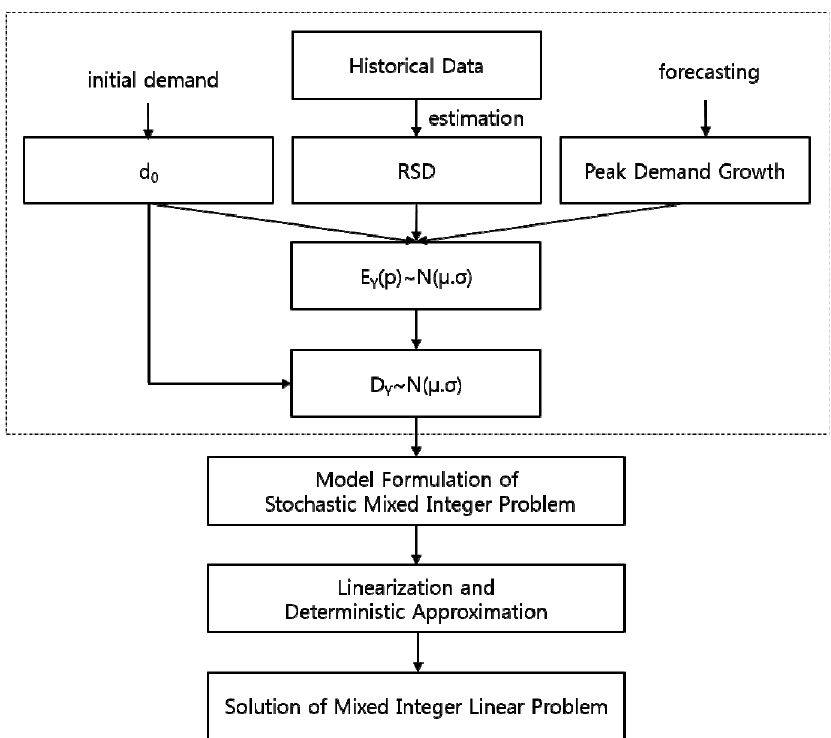
Figure 6. Solution procedure–proposed TEP method.